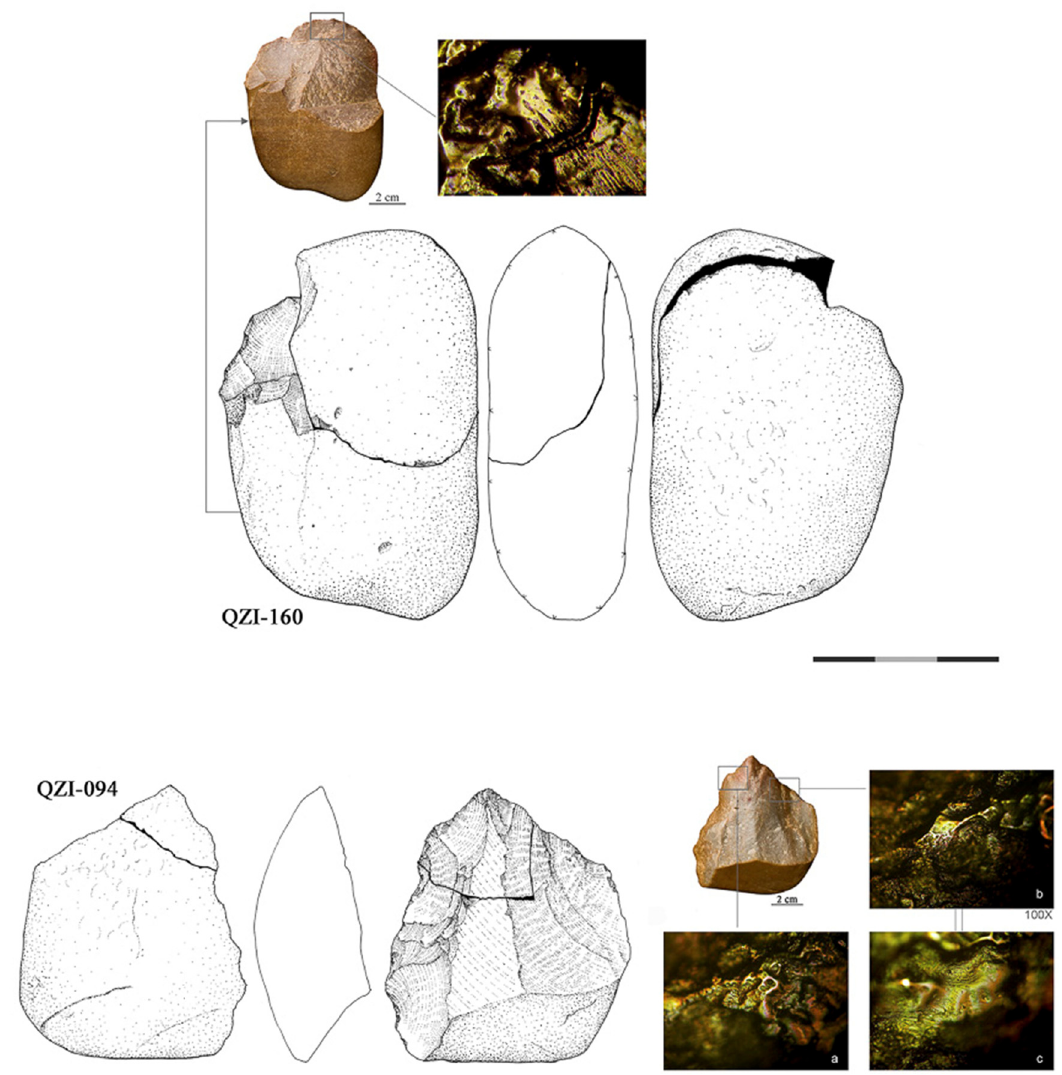
Figure 13: Barca do Xerez de Baixo: these quartzite re fi ttings illustrate cases in which the gaps between the core and the reassembled blank seem to indicate the use of the core as a tool, a hypothesis later con fi rmed by use - wear analyses, in both cases for woodworking materials. Drawing, K. Monigal; macro and micro photos, M. A. Igreja.